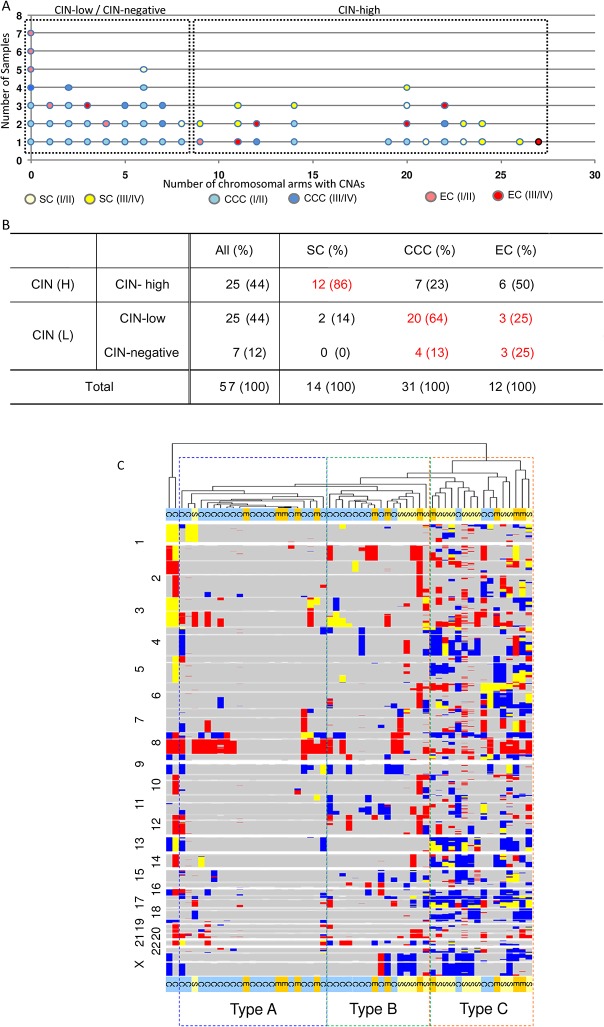
SNP profiling discriminates histology-related subgroups based on chromosomal instability status.Chromosomal instability status (CIN) according to the number of allele-specific copy number alterations (CNAs) and copy number neutral loss of heterozygosity (CNN LOH), using a human mapping 250K single nucleotide polymorphism (SNP) array with paired tumor DNA and normal DNA. CNAs were divided into three subgroups: CIN-high (≥9 arms with CNAs), CIN-low (1–8 arms with CNAs), and CIN-negative (0 CNAs). (A) Details of number of chromosomal arms with CNAs in each tumor of three histological subtypes (serous carcinomas, SC; clear cell carcinomas, CCC; endometrioid carcinomas, EC). Stage I/II and stage III/IV are colored differently. (B) Correlation between CIN status and histological subtypes. (C) Overview of CNAs by running SNP arrays with 57 ovarian cancer samples. Hierarchical clustering based on the Euclidean distance for dissimilarities is shown. The type A cluster includes tumors with a broad range and low frequency of CNAs, whereas the type B cluster includes tumors with a focal range and high frequency of CNAs. C, E, and S indicate clear cell carcinoma, endometrioid carcinoma, and serous carcinoma, respectively.